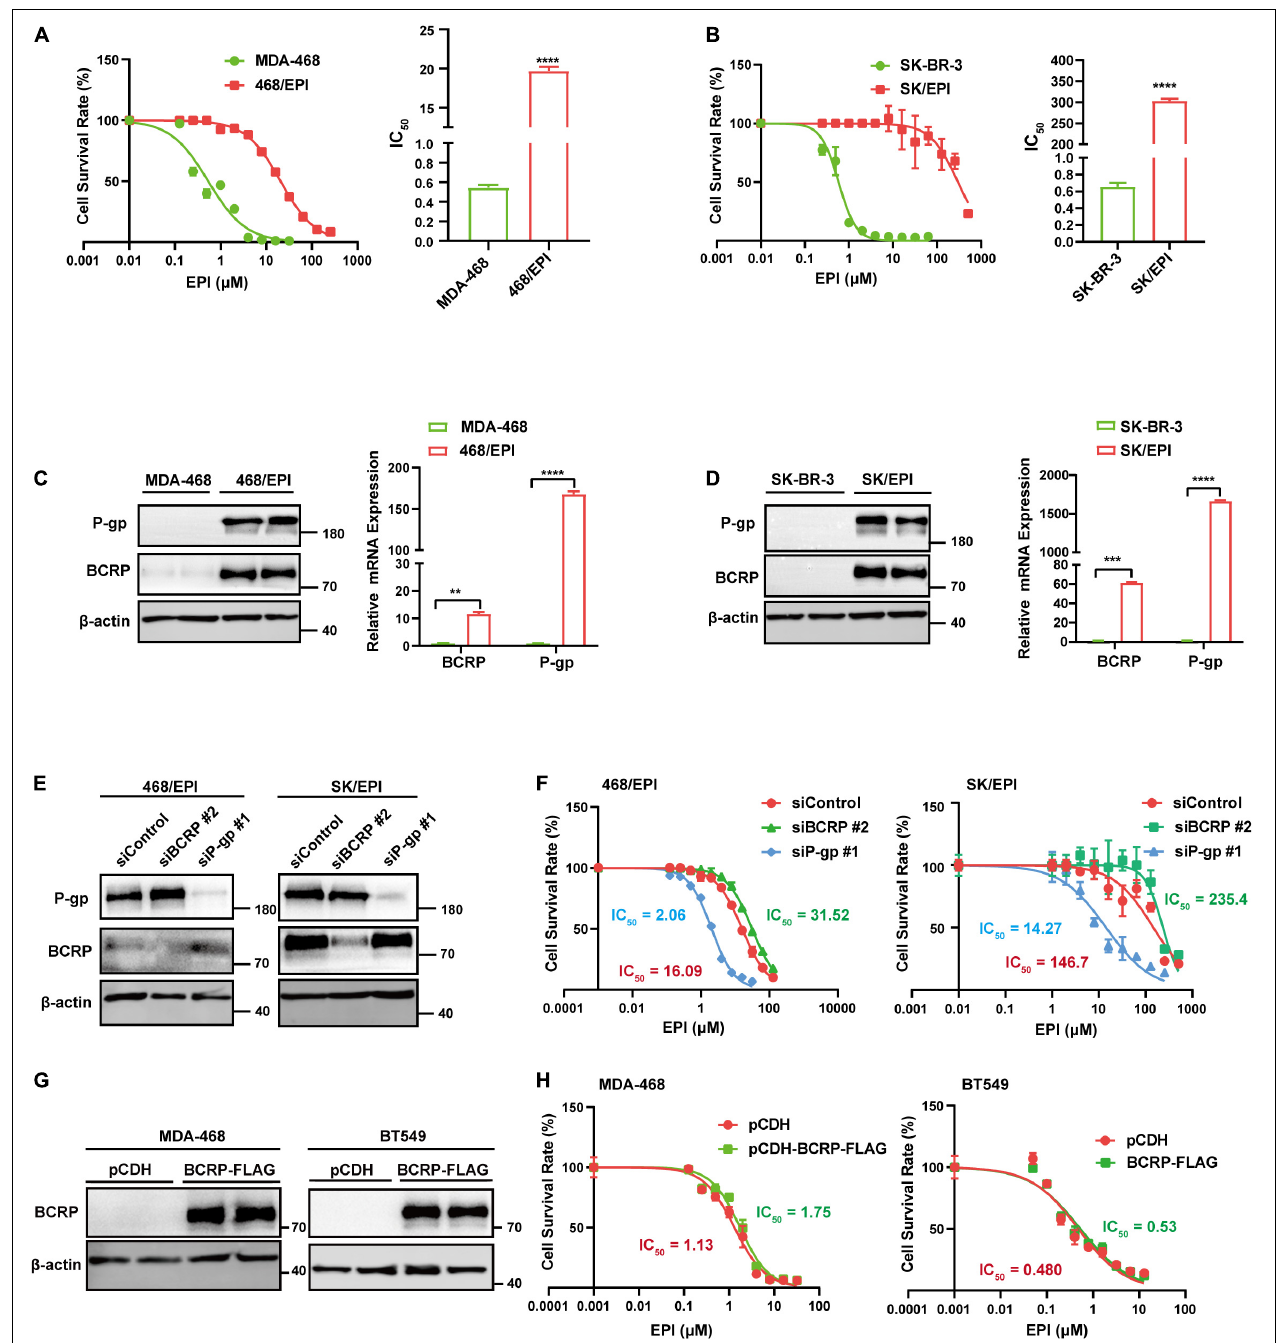
FIGURE 1 | BCRP is not the dominant efflux pump in drug-resistant cells with multiple activated ABC transporters. (A) Dose–response curve of MDA-MB-468 (MDA-468) and MDA-MB-468/EPI (468/EPI) cells. The 468/EPI cells displaced enhanced resistance to EPI compared with parental cells. The cells were incubated in EPI-containing medium for 72 h. (B) Dose–response curve of SK-BR-3 and SK-BR-3/EPI (SK/EPI) cells. SK/EPI cells displayed enhanced resistance to EPI compared with parental cells. The cells were incubated in EPI-containing medium for 72 h. (C,D) P-gp and BCRP were significantly upregulated in 468/EPI (C) and SK/EPI (D) cells compared with that in parental cells, as shown by Western blot and qRT-PCR assays. (E) Western blot analysis of P-gp and BCRP protein expression in 468/EPI and SK/EPI cells treated with siBCRP, siP-gp, or control siRNAs. (F) Dose–response curves of 468/EPI and SK/EPI cells treated with siBCRP, siP-gp, or control siRNAs. The cells were incubated in EPI-containing medium for 72 h. (G) Western blot analysis shows that BCRP was overexpressed in MDA-468 and BT549 cells by BCRP-overexpressing lentivirus. (H) Dose–response curves of MDA-468 and BT549 cells with or without BCRP overexpression. The cells were incubated in EPI-containing medium for 72 h. All data are shown as the mean ± SD; ** p < 0.01, *** p < 0.001, **** p < 0.0001 and ns p > 0.05 versus control, N = 3.